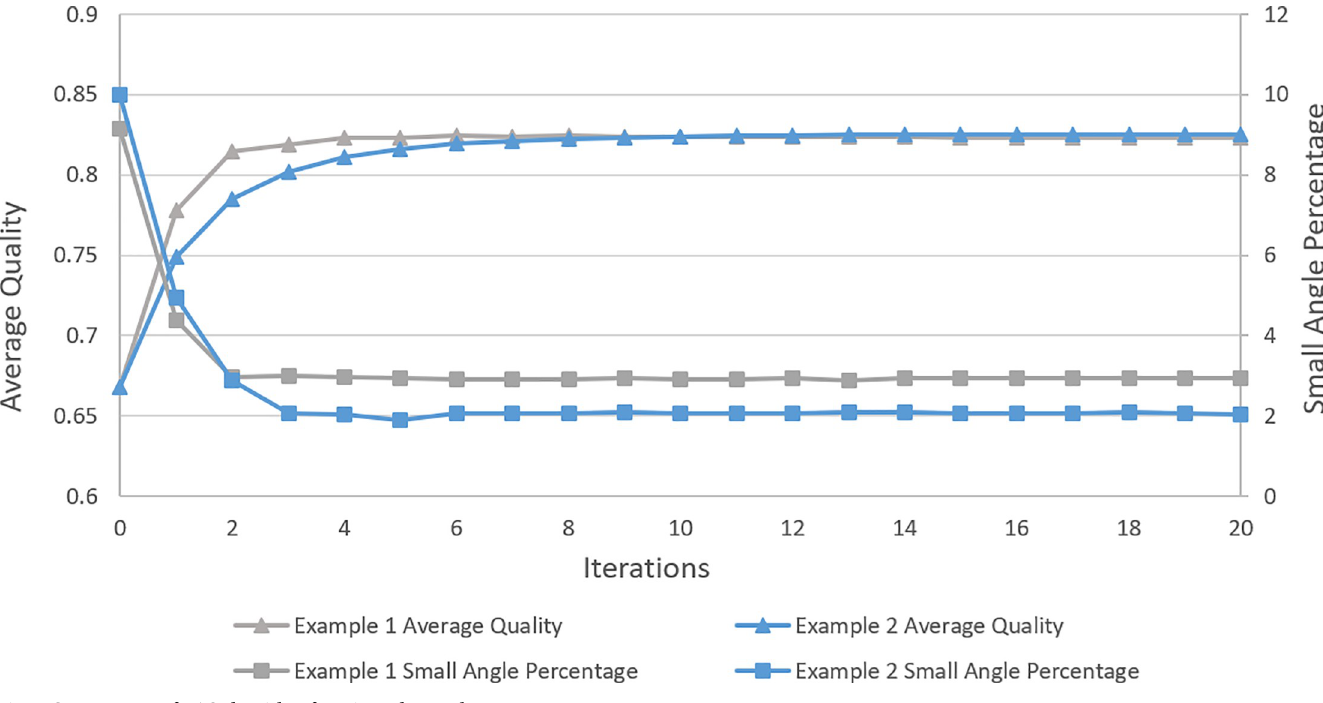
Fig 6. Convergence of EAS algorithm for triangular